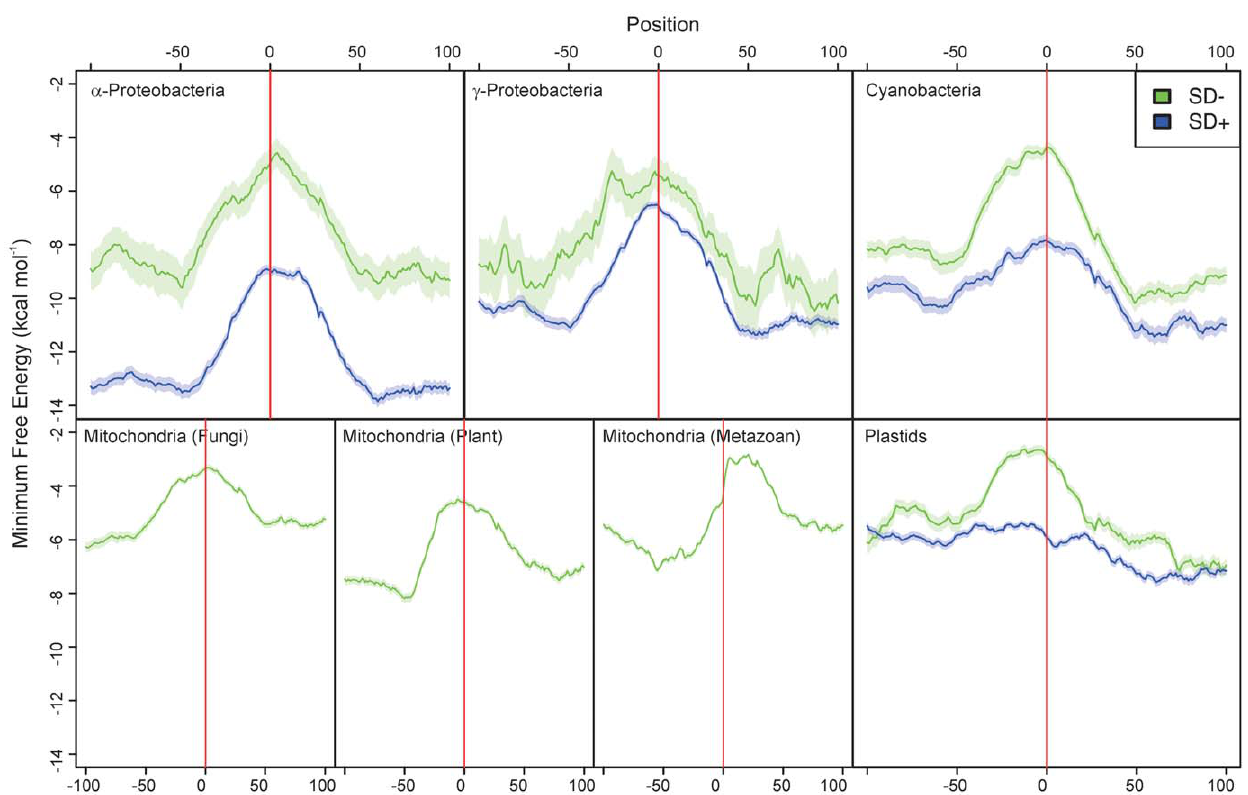
Figure 2. The amount of RNA secondary structure predicted around the start codon in a -proteobacteria, c -proteobacteria, cyanobacteria, plant, metazoan and fungal mitochondria, and plastids. Position 0 is the first nucleotide of the start codon. Genes without an SD sequence are represented by green curves, those with an SD by blue curves. The line shows the running mean minimum free energy of 5000 genes, the shaded area around it indicates the standard error of the mean. The minimum free energy was determined using a sliding window covering 50 nucleotides. The difference in MFE between the green and blue curves upstream and downstream of the initiation region in the three bacterial groups is largely due to differences in AT-content between genomes within an individual organismal group and a correlation between AT- richness and prevalence of SD-independent translation. The MFE difference disappears when individual genomes are analyzed (Figure S1). Note that, in metazoan mitochondria, the peak of the minimum free energy is shifted into the coding region, because most transcripts in animal mitochondria are leaderless and lack a 5 9 UTR.